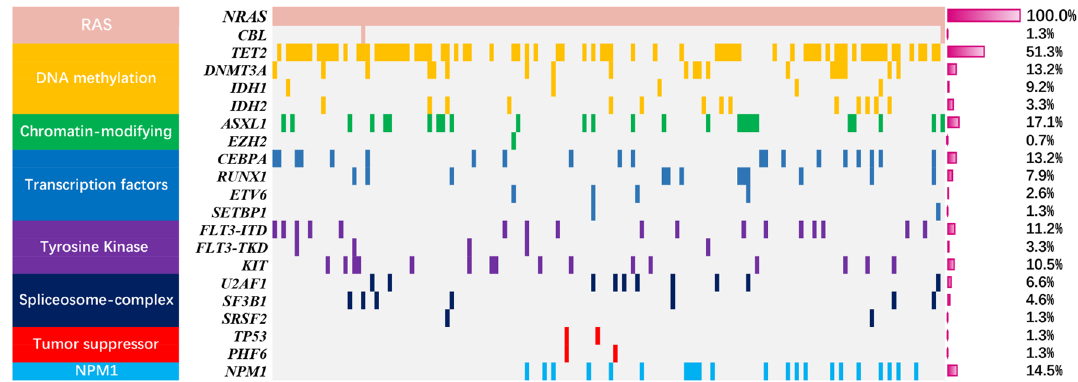
Figure 2. Mutational landscape of 152 NRAS mut AML patients. The landscape showed all genetic aberrations for each patient. The boxes in one column represent single patient cases. Mutations were color coded by mutation type. The histogram on the right showed the frequency distribution of all